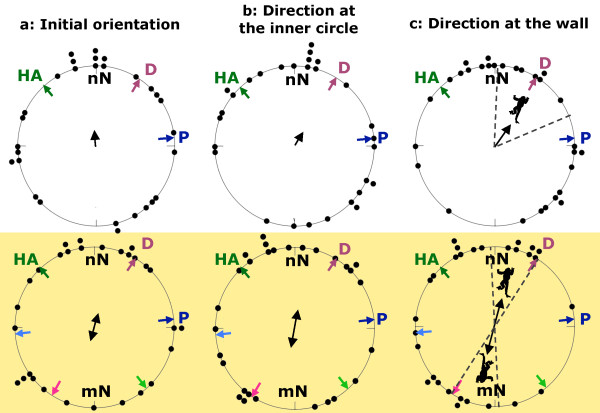
Results. Bearings and mean directions of the initial orientation (a), orientation at the inner circle (b) and orientation at the wall of the arena (c); in the figure the radius of the circle corresponds to a mean vector length (r) equal to one. Graphs in the upper row show the results obtained under natural conditions, graphs in the lower row (highlighted) those obtained with the reversed magnetic field (n = 29 in all cases). Dashed lines indicate the 95% confidence intervals in cases of significant orientation (P < 0.05). Under natural conditions the magnetic North (mN) coincided with the true north direction (nN), whereas in the reversed field mN was opposite to nN. Coloured arrows indicate the direction to the pond (P), the direction from the hibernation area to the pond (HA) and the mean direction along the drift fence (D). In the case of the reversed field, corresponding arrows are placed on the opposite side, in paler colours, to illustrate the directions when following only the magnetic field.